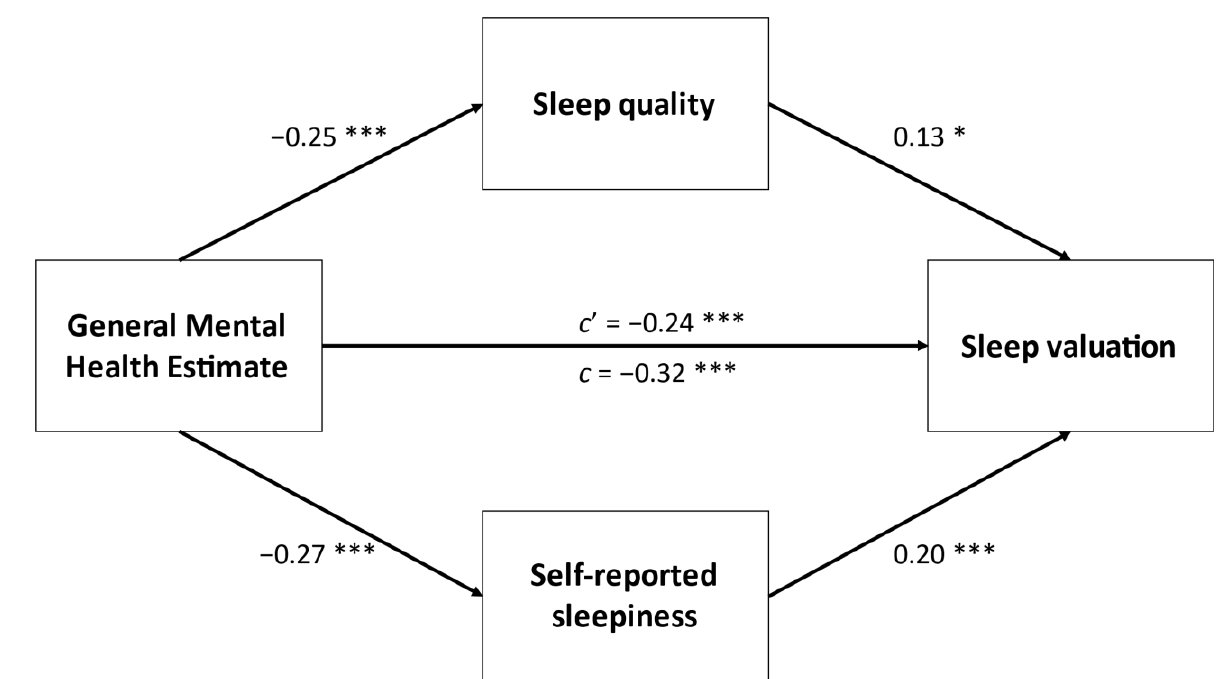
Figure 3. Parallel mediation between self-reported general mental health estimate and sleep valuation. Values are standardized β . * p < 0.05, *** p < 0.001.